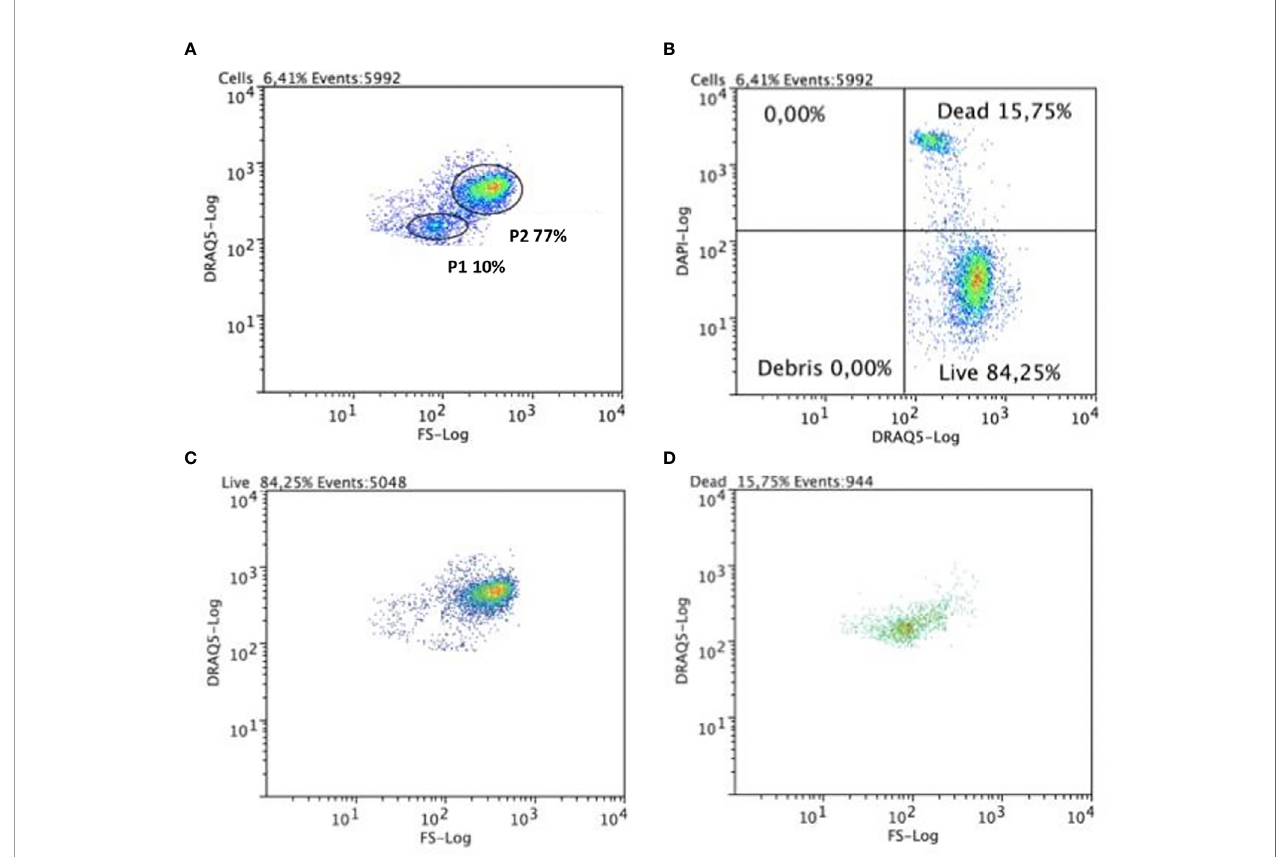
FIGURE 2 | Flow cytometric analysis of circulating coelomocytes viability. Cells were stained with DRAQ5 and DAPI. (A) Representative dot plot with P1 and P2 cell populations gated. (B) A quadrant plot of coelomocytes showing DAPI+ DRAQ5+ (dead) and DRAQ5+ DAPI- (alive) coelomocytes. (C) A dot plot showing that in the living cells quadrant, these belong mainly to the P2 cell population. (D) A dot plot showing that cells in the dead cells ’ quadrant belong mainly to P1 cell